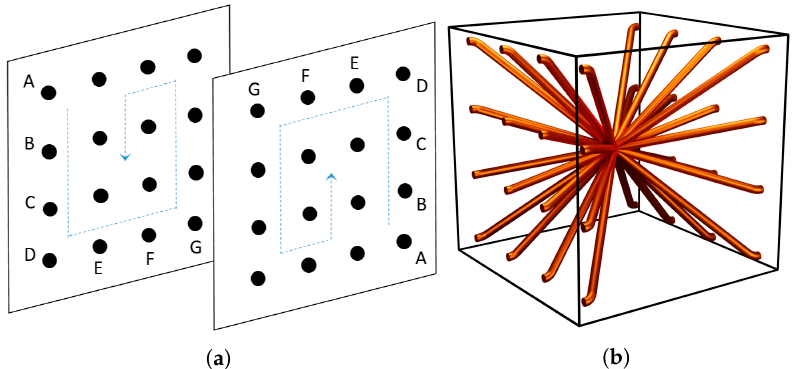
Figure 13. Connection schema A ( a ) Connection schema with point-symmetric positions to enforce collisions. ( b ) 4 enforced